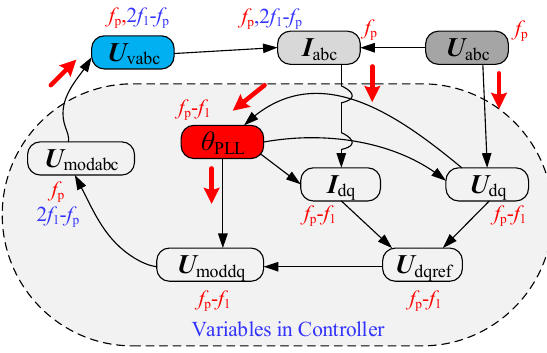
Figure 3. Transfer process of disturbances in internal variables of grid-side converter.